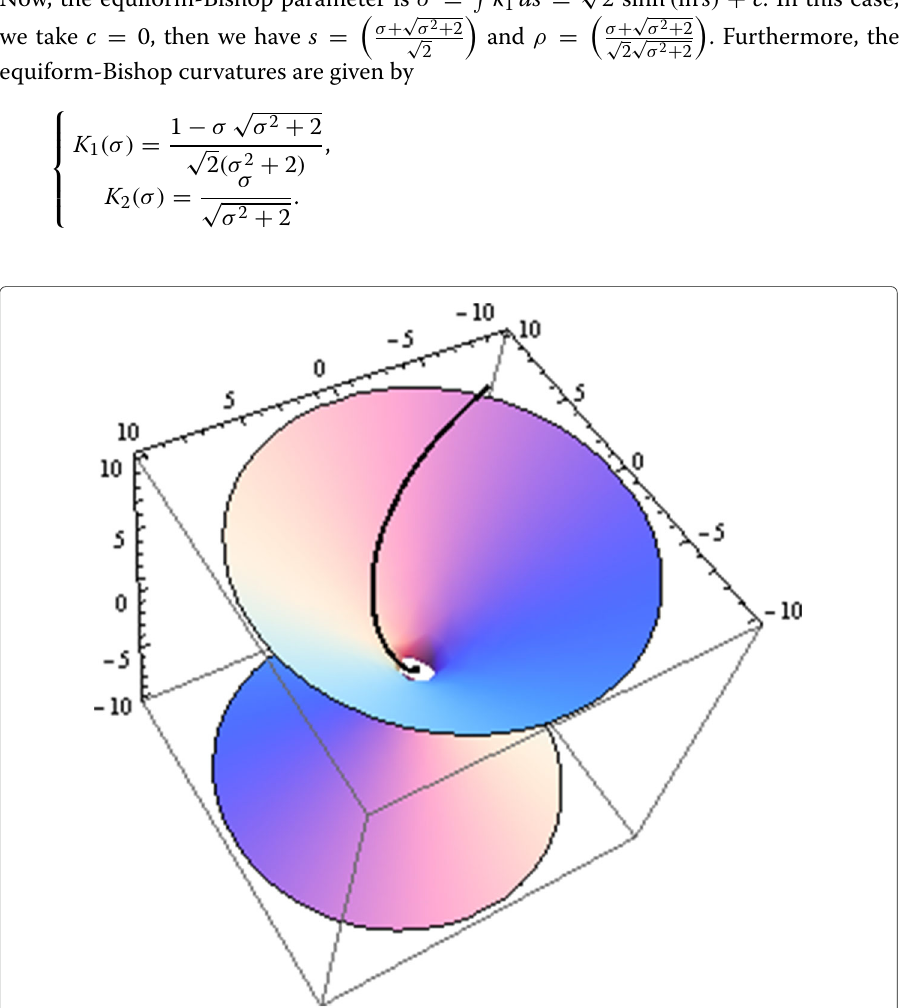
Fig. 2 Spacelike equiform-Bishop curve r = r (σ) on S 2